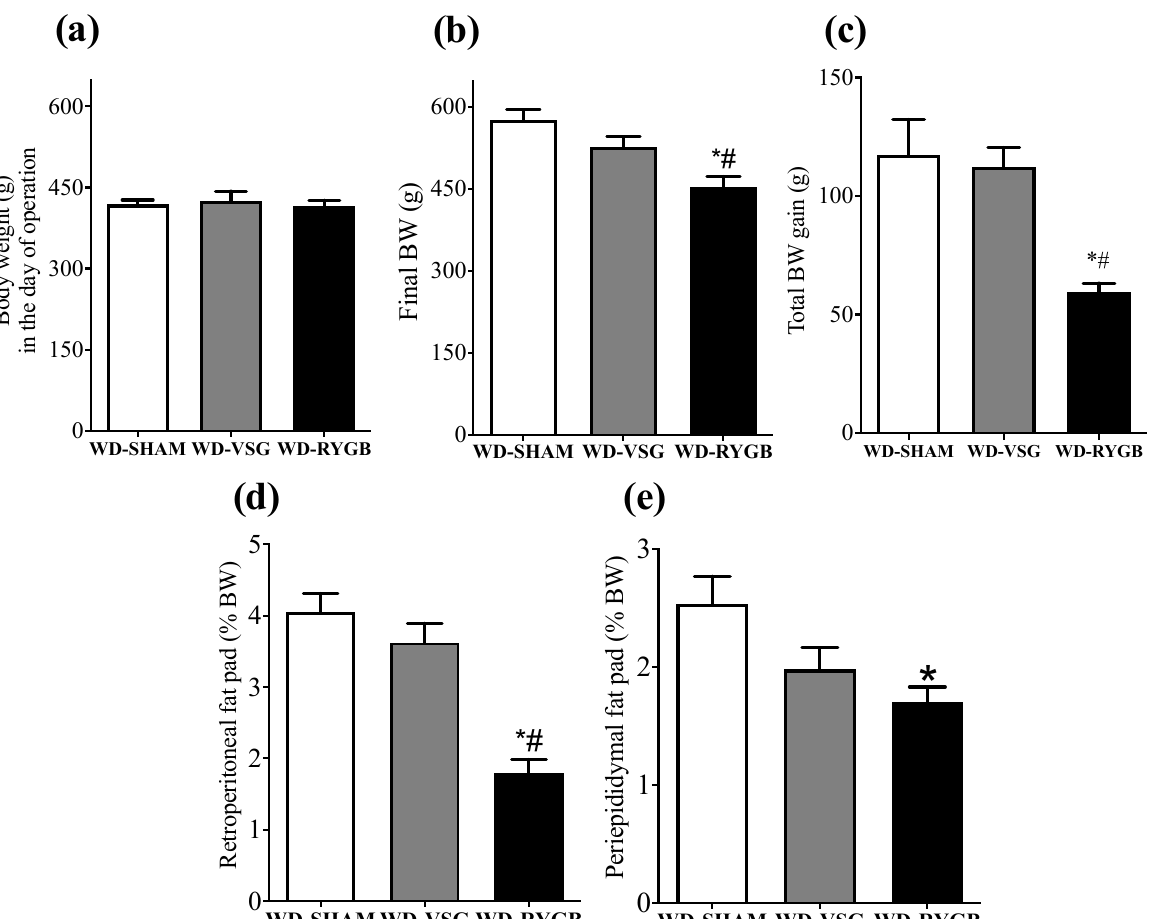
Figure 2. Means ± SEM of BW in the day of operation (a), final BW (b), total BW gain (c), and weights of retroperitoneal (d) and periepididymal (e) fat pads of WD-SHAM (n=8), WD-RYGB (n=9) and WD-VSG (n=6) rats. *different from WD-SHAM; #different from the other type of bariatric operation (Kruskal-Wallis followed by Dunns post test, P <